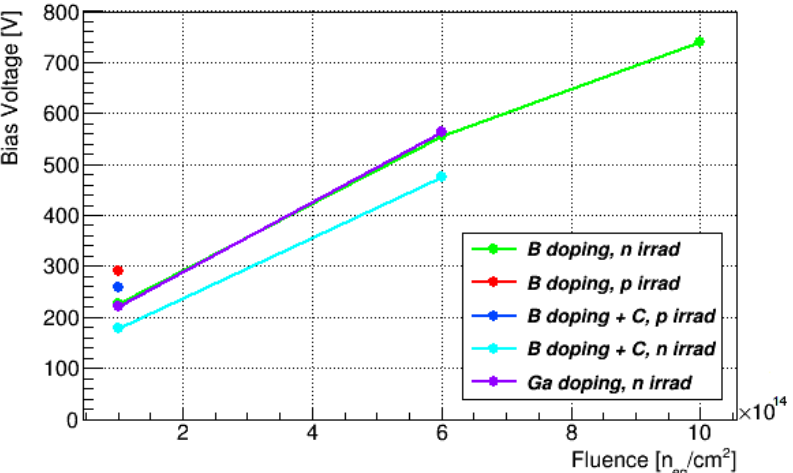
Figure 10. Maximum operating voltage for an auto-triggering rate of 1kHz as a function of the fluence for CNM LGADs at −